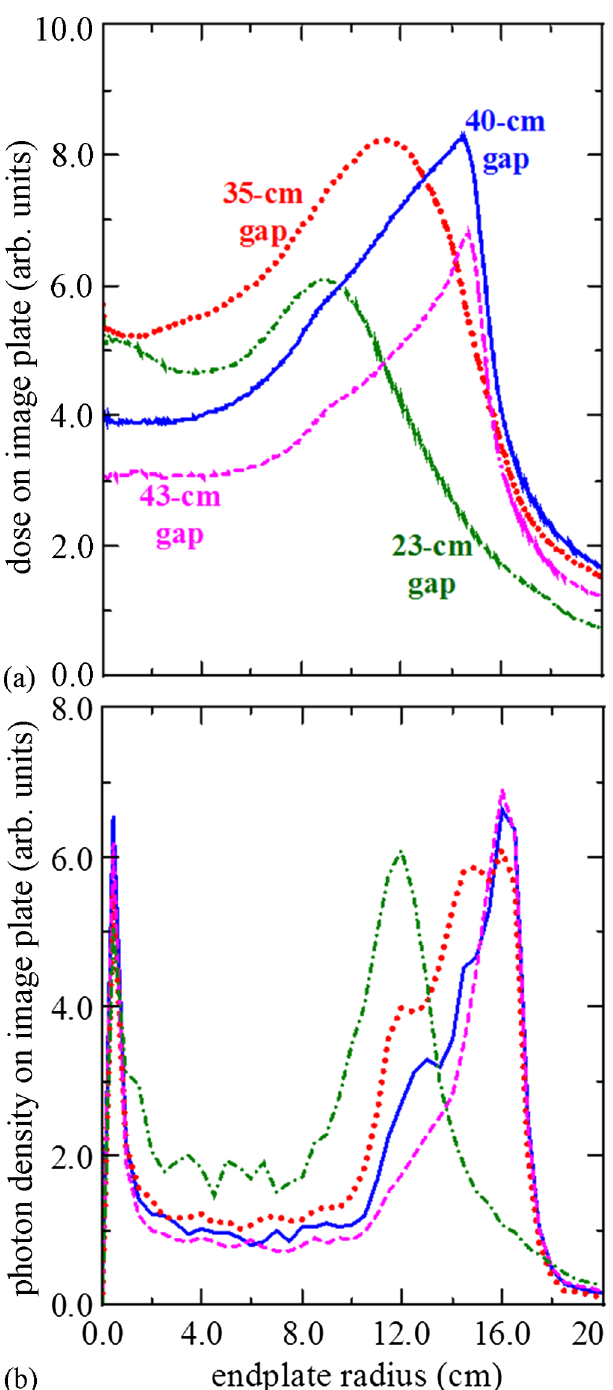
FIG. 8. (a) Radial distribution of dose on the endplate inferred from the pinhole-camera image-plate intensity for different AK gaps. (b) Radial distribution of x-ray intensity on the endplate from LSP/ ITS simulations of different AK gaps. Curve labels are as in Fig.